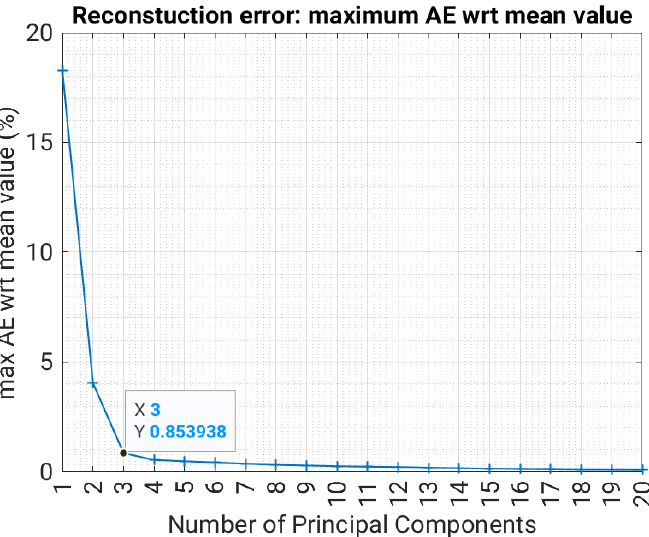
Figure 5. Reconstruction error as a function of the number of principal components for Dataset 1. With three principal components (PCs), the maximum absolute error is below the 0.85% of the mean absolute field value for Datasets 1 and 2, while it is below 0.5% for Dataset 3. At this point, we can efficiently represent the A matrices in a lower-dimensional space using just three or four principal components.